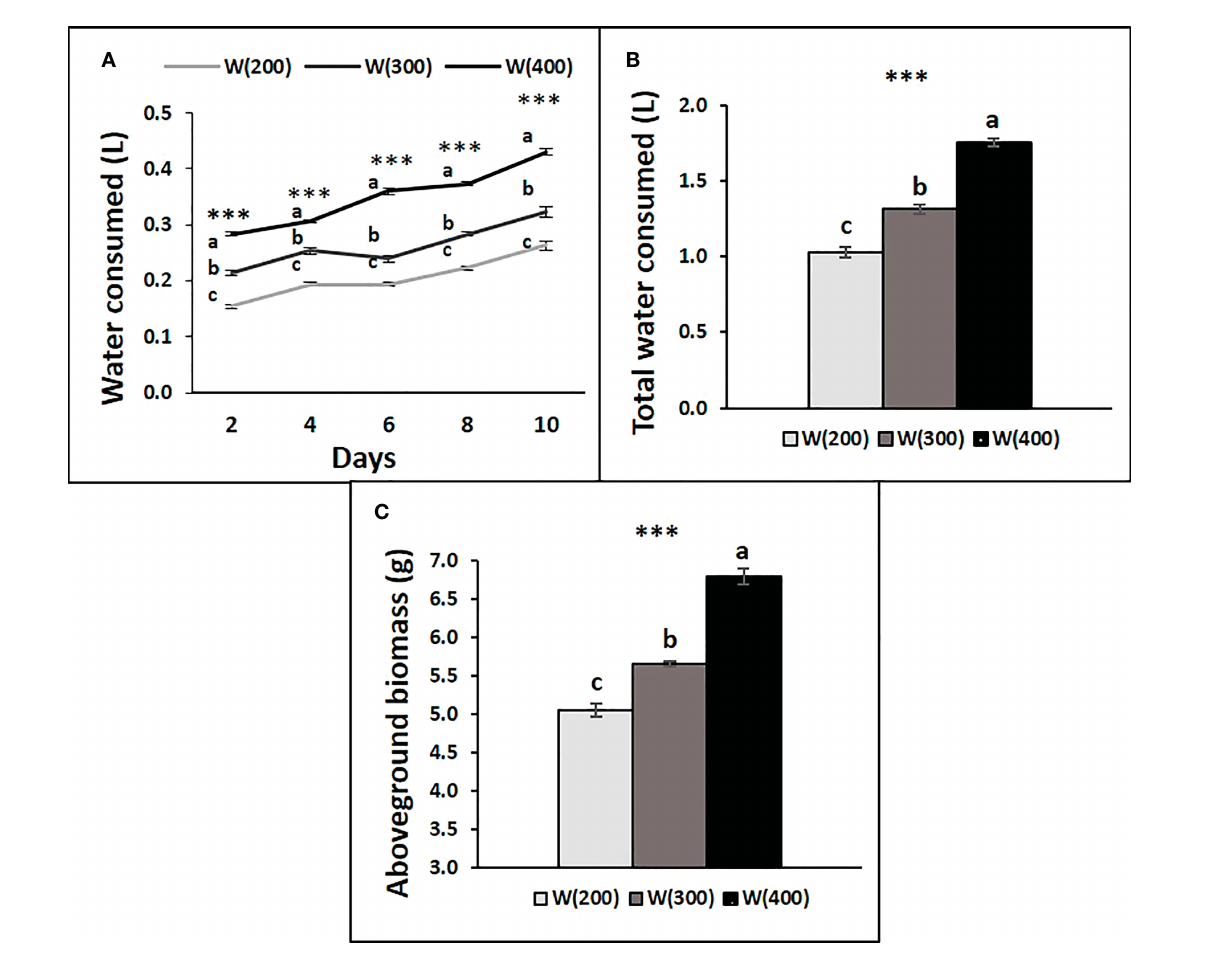
FIGURE 6 Water consumption by tray of perennial ryegrass (cv. Double) after time zero, every two days (A) , accumulated at the end of the experiment (B) , and aboveground biomass accumulated by tray at the end of the experiment (g DW, C ), under different LED illumination regimes, 100% cool white at 200 [W(200)], 300 [W(300)] and 400 [W(400)] m mol m − 2 s − 1 . Each point and column are average and vertical bars represent the S.E. (n = 3). Different letters indicate signi fi cant differences among the treatments (***,